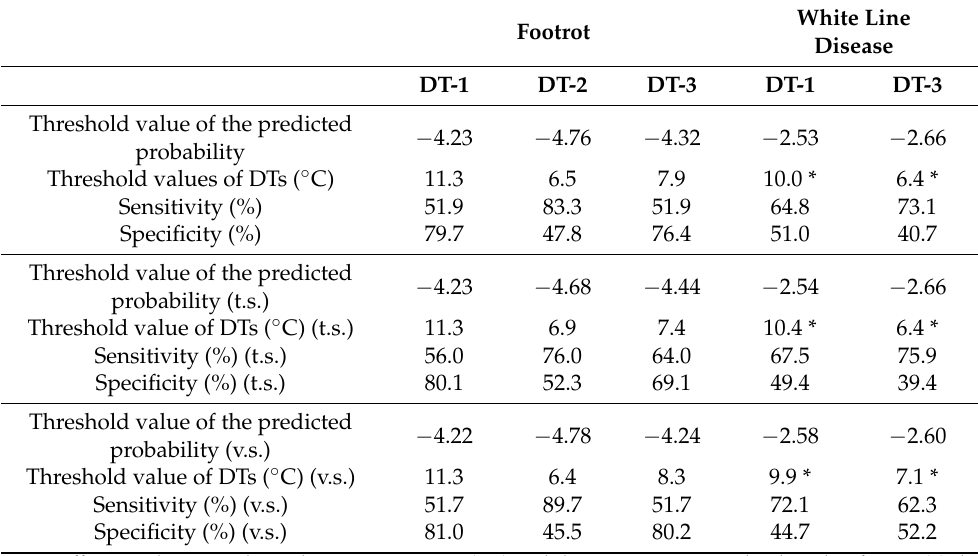
Table 3. The optimal efficiency thresholds for the predicted probabilities and the temperature differences between the studied hoof sites and the ambient temperature, sensitivity, and specificity, as estimated by the binary regression models for the total database, the training sample, and the validation